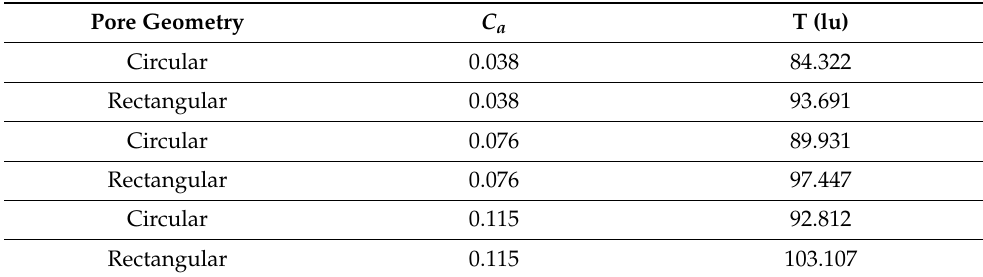
Figure 8. Schematic illustration of gas penetration. Table 3. Comparison of effective penetration length T for different pore geometries at different C a and t ∗ =